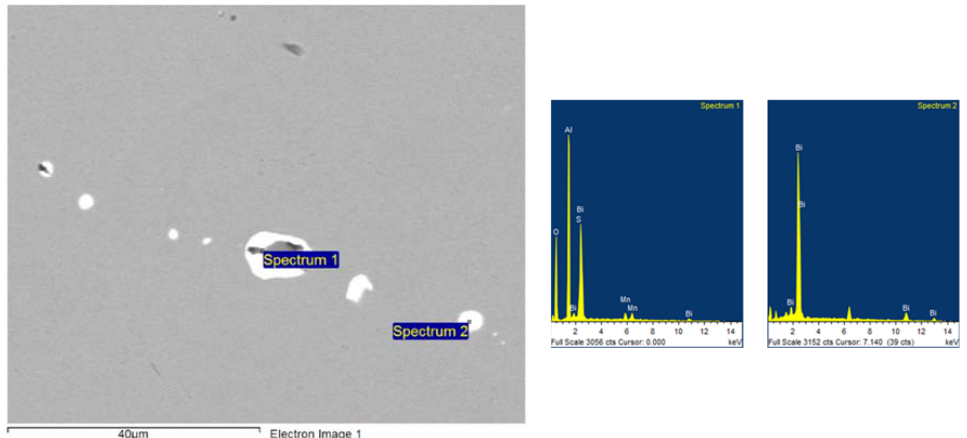
Figure 10. EDX spectra of individual particles in CMnCr steel with 0.08% Bi. Table 4. Chemical composition [in wt. %] of individual areas in inclusions, CMnCr steel with 0.08 wt. % Bi [wt. %]. Elements